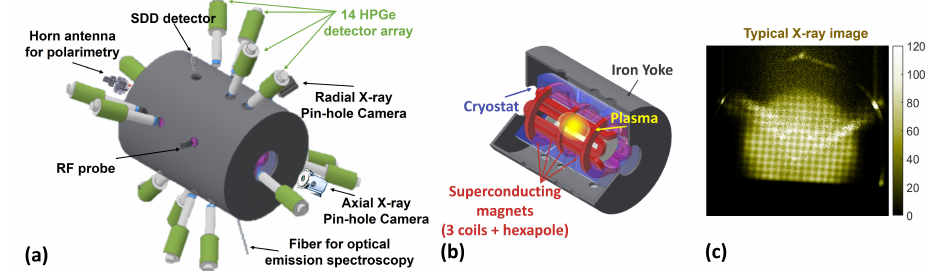
Figure 1. (a) Rendering of the PANDORA trap with the experimental setup for measuring the in-plasma activity (14 HPGe detector array) and on-line monitoring n e and T e (i.e., two X-ray CCD cameras, optical spectrometer, interfero-polarimetry, two-pin RF probe, SDD). (b) Sketch of the superconducting magnetic system (red), cryostat (blue) and iron yoke (grey). (c) Typical Argon energy-filtered X-ray